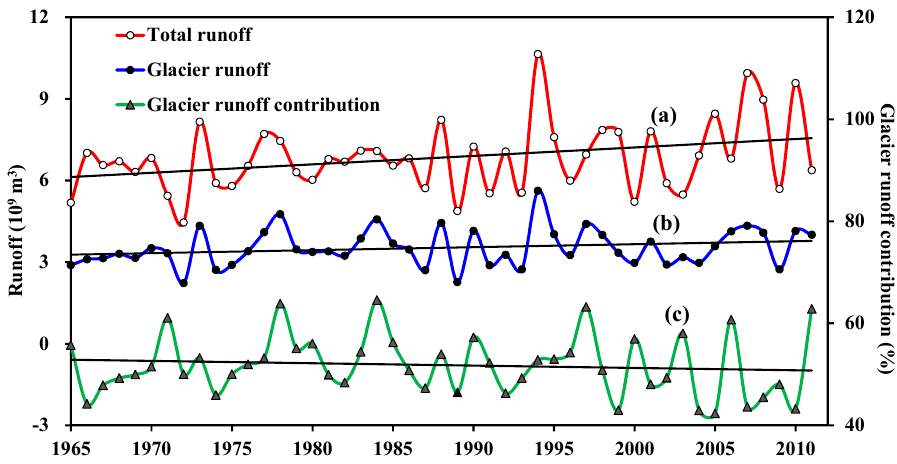
Figure 6. Simulated annual total runoff, glacier runoff, glacier runoff contribution, as well as their variation trends.